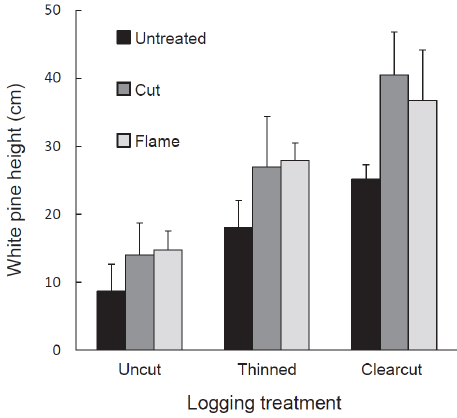
Figure 4. Height (cm) of eastern white pine seedlings (tallest seedling per 8 m 2 plot) in relation to logging treatment (uncut control, thinned, clearcut) and buckthorn treatment (untreated, cut, flame) at MacDonald Lot, Durham, NH, USA, in 2012, the third year after logging. n = 27 subplots.